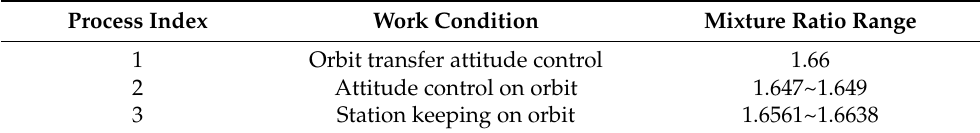
Table 1. The mixture ratio range of the attitude control thruster under typical work